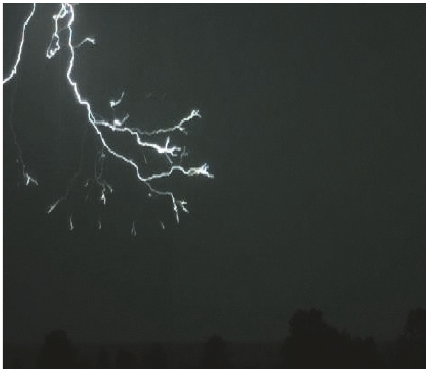
Figure 1: Lightning discharge and stepped leader